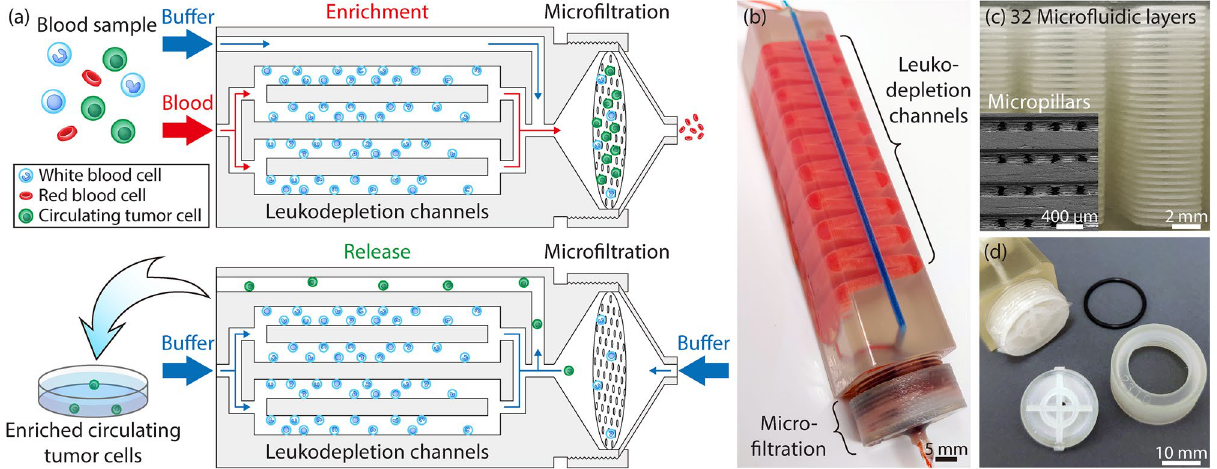
Figure 1. The design and operation principle of the 3D-printed microfluidic device. ( a ) Schematic illustrations of the circulating tumor cell enrichment process using the developed device. The device discriminates CTCs from normal blood cells by eliminating leukocytes through immunodepletion and anucleated blood cells through their smaller size. The enriched CTCs are then released into a petri dish under reverse flow. ( b ) A photo of the 3D-printed microfluidic device. Red and blue color dyes are injected through the inlets to visualize the multi-layered leukodepletion channels and washing buffer channel, respectively. ( c ) A close-up photo showing the stacked 32 leukodepletion channels and (inset) an SEM micrograph showing cross-section of the channels, where the micropillars within the channels can be seen. ( d ) A photo of the microfiltration stage and associated components. The filter support assembly uses an O-ring to prevent leakage during operation and a threaded lock to secure the entire for our filter design to retain the majority of nucleated cells from whole blood, while passing much smaller RBCs and platelets. In assembling the final device, a separately fabricated membrane filter was sandwiched between two support layers with O-ring in place to prevent leakage. A threaded lock secured the whole filter compart- ment assembly. This particular design of the microfiltration compartment allowed direct access for inserting and removing the thin PDMS membrane filter and held the membrane stable during uncapping, which ensured against potential shear damage. Optimization of the antibody coverage on the device surface. To specifically capture WBCs from among other blood cells, we chemically functionalized the inner surfaces of our device against CD45, a mem- brane antigen commonly expressed by different WBC subpopulations 40 . To prime the device for antibody immo- bilization, we employed a modified version of the functionalization protocol developed by Stott et al. 42 Prior to surface functionalization, the PDMS membrane filter was activated in oxygen plasma and then integrated into the 3D-printed microfluidic device. A series of chemical reagents (“Methods”) were introduced from the sample inlet towards the waste to coat both the stacked microfluidic channels and the membrane filter at once. Anti- CD45 antibodies were then attached to the primed device surface through avidin–biotin interaction (Fig. S1a). To maximize the immunocapture efficiency, we next determined the optimal concentration of antibodies that would ensure complete surface coverage. In this process, antibody concentrations ranging from 0.5 to 20 µg/ mL were applied on an analytical version of the 3D-printed device and the PDMS membrane filter separately to account for potential disparity due to different materials. To measure antibody coverage in our tests, immo- bilized mouse anti-CD45 antibodies were labeled with a secondary antibody, Alexa Fluor 488 goat anti-mouse IgG (Invitrogen, Carlsbad, CA), at a manufacturer-suggested concentration of 1 µg/mL, and the resulting surface fluorescence intensity was measured with a fluorescence microscope (Fig. S1b). Measurements on the 3D-printed and PDMS surfaces were acquired under identical exposure settings for comparison, and all signals were nor- malized against the measured background fluorescence. While we observed ~ 40% more fluorescence on the PDMS surface at the limit, both surfaces were found to saturate at similar points with the surface fluorescence intensity rapidly increasing only with antibody concentrations of < 10 µg/mL. Because the fluorescence signal remained virtually unchanged (< 3% difference) for concentrations > 10 µg/mL, we chose 10 µg/mL as the opti- mal concentration for antibody immobilization. This resulted in consuming ~ 30 µg of anti-CD45 antibody for functionalizing the whole device (immunodepletion channels and filter), which costed ~ $15.8 per test. Negative depletion of white blood cells with the chemically functionalized filter. To assess the contribution of a downstream anti-CD45-functionalized filter in depleting white blood cells, we separately tested the membrane filter outside of the device (Fig. 2a). Forward flow rates for both the sample and the buffer were set based on our earlier work that used a track-etched filter with 3 µm-diameter pores 41 . To mimic the filter operating conditions when it is in the device (i.e., a buffer mixing with whole blood during the filtration stage), we simultaneously introduced 200 µL of whole blood spiked with MDA-MB-231 human breast tumor cells, which had a measured size distribution of 5.9 µm to 19.8 µm (Fig. S2), at 2 mL/h and PBS washing buffer